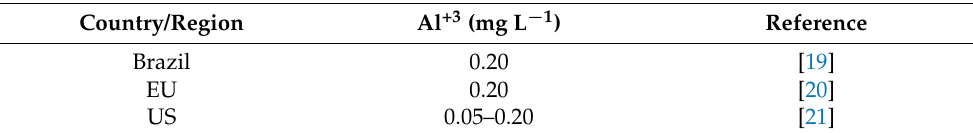
a Common letters beside means indicate values are not statistically different from each other according to